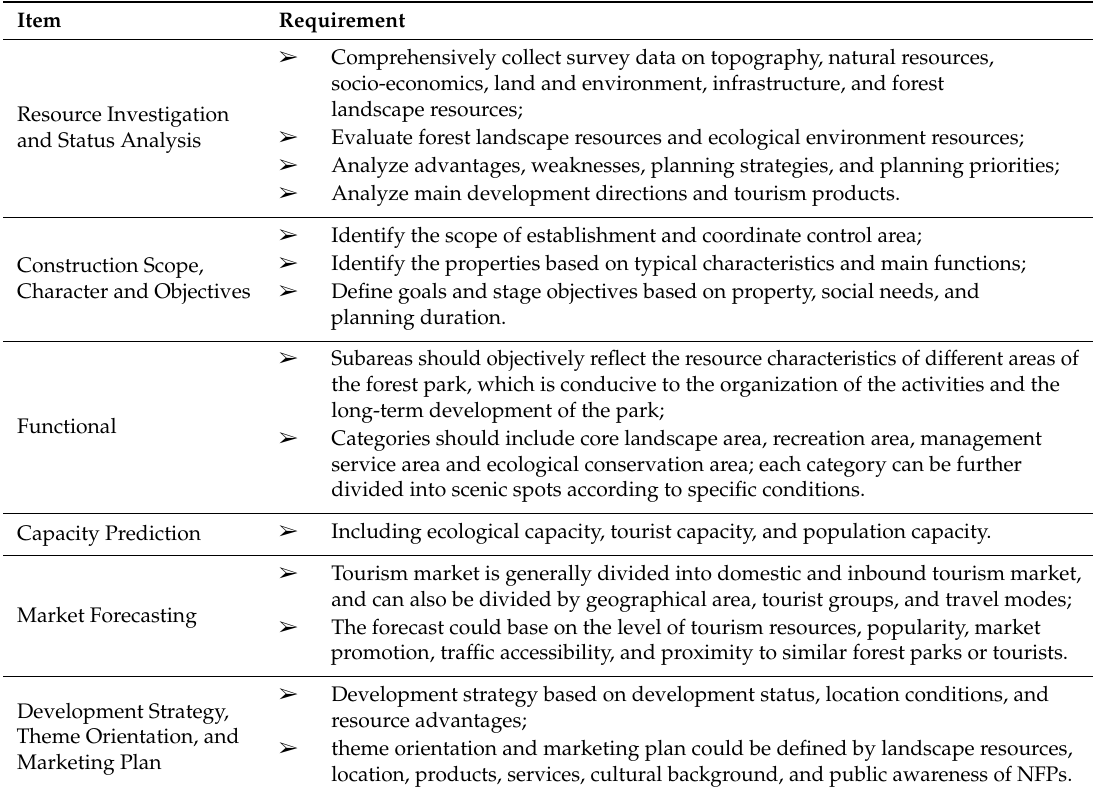
Table 2. Planning items and requirements for NFPs (Information collected from the document of Guideline for Master Planning of National Forest Park